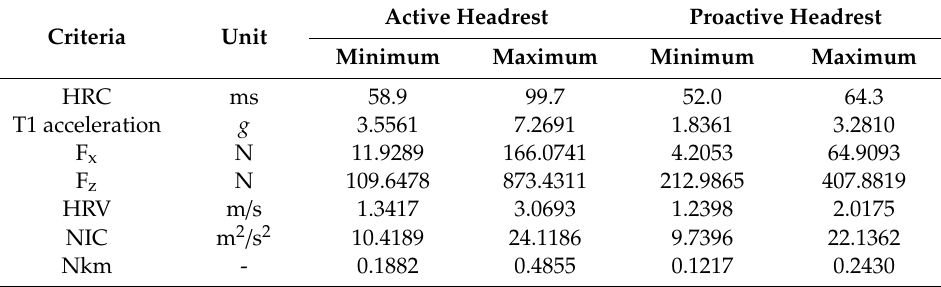
Table 3. Results of sled test for active headrest and proactive